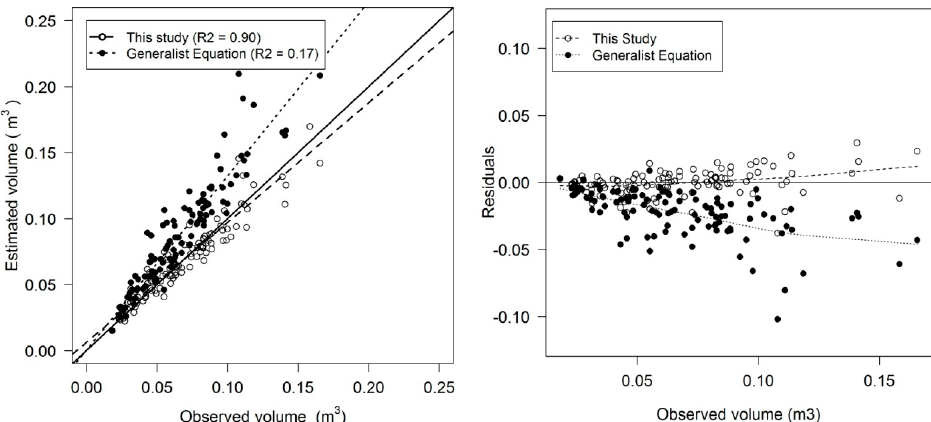
Figure 5. ( Left ) Comparison of allometric equations of volume using the values estimated by “Species Equation” and “Generalist Equation” used in the Amazon in relation to the values observed in rosewood plantations in the study sites and; ( Right ) Comparison of allometric equations of volume using residues distribution .